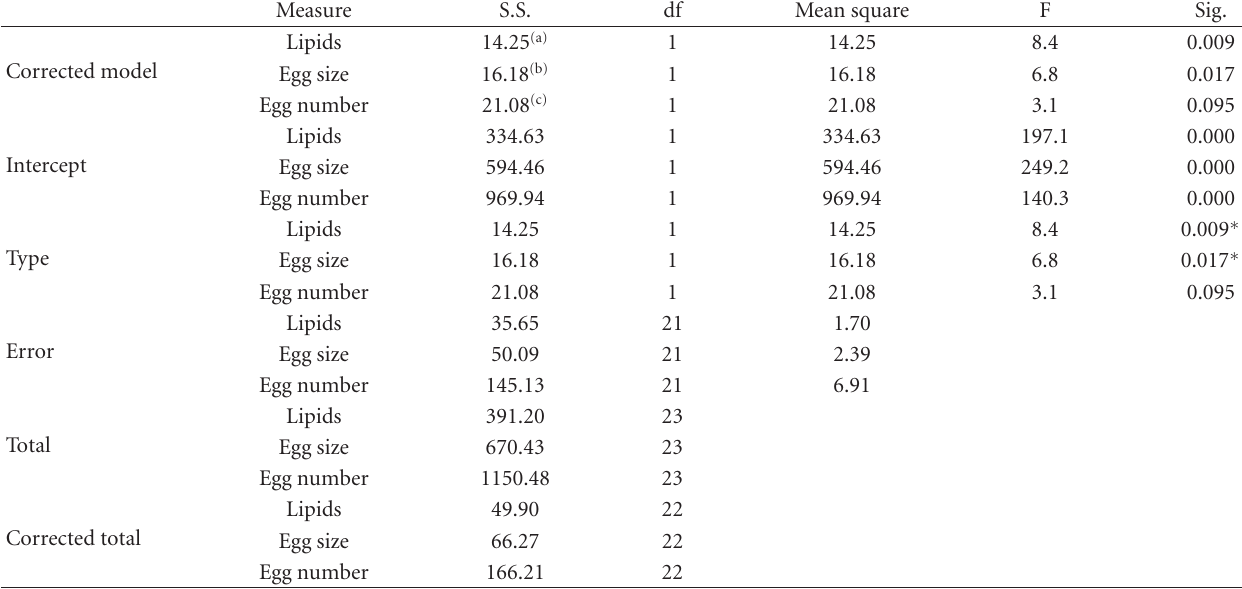
Table 3: ANOVA table showing the significant e ff ect of symbiont Type (C2, D) on pre- and postspawning lipids and egg size (mm 2 ) in Acropora millepora colonies before the bleaching. The corrected model shows the variation in the dependent variable by other e ff ects (other than the intercept) after correction for the mean. ∗ indicate significant results.